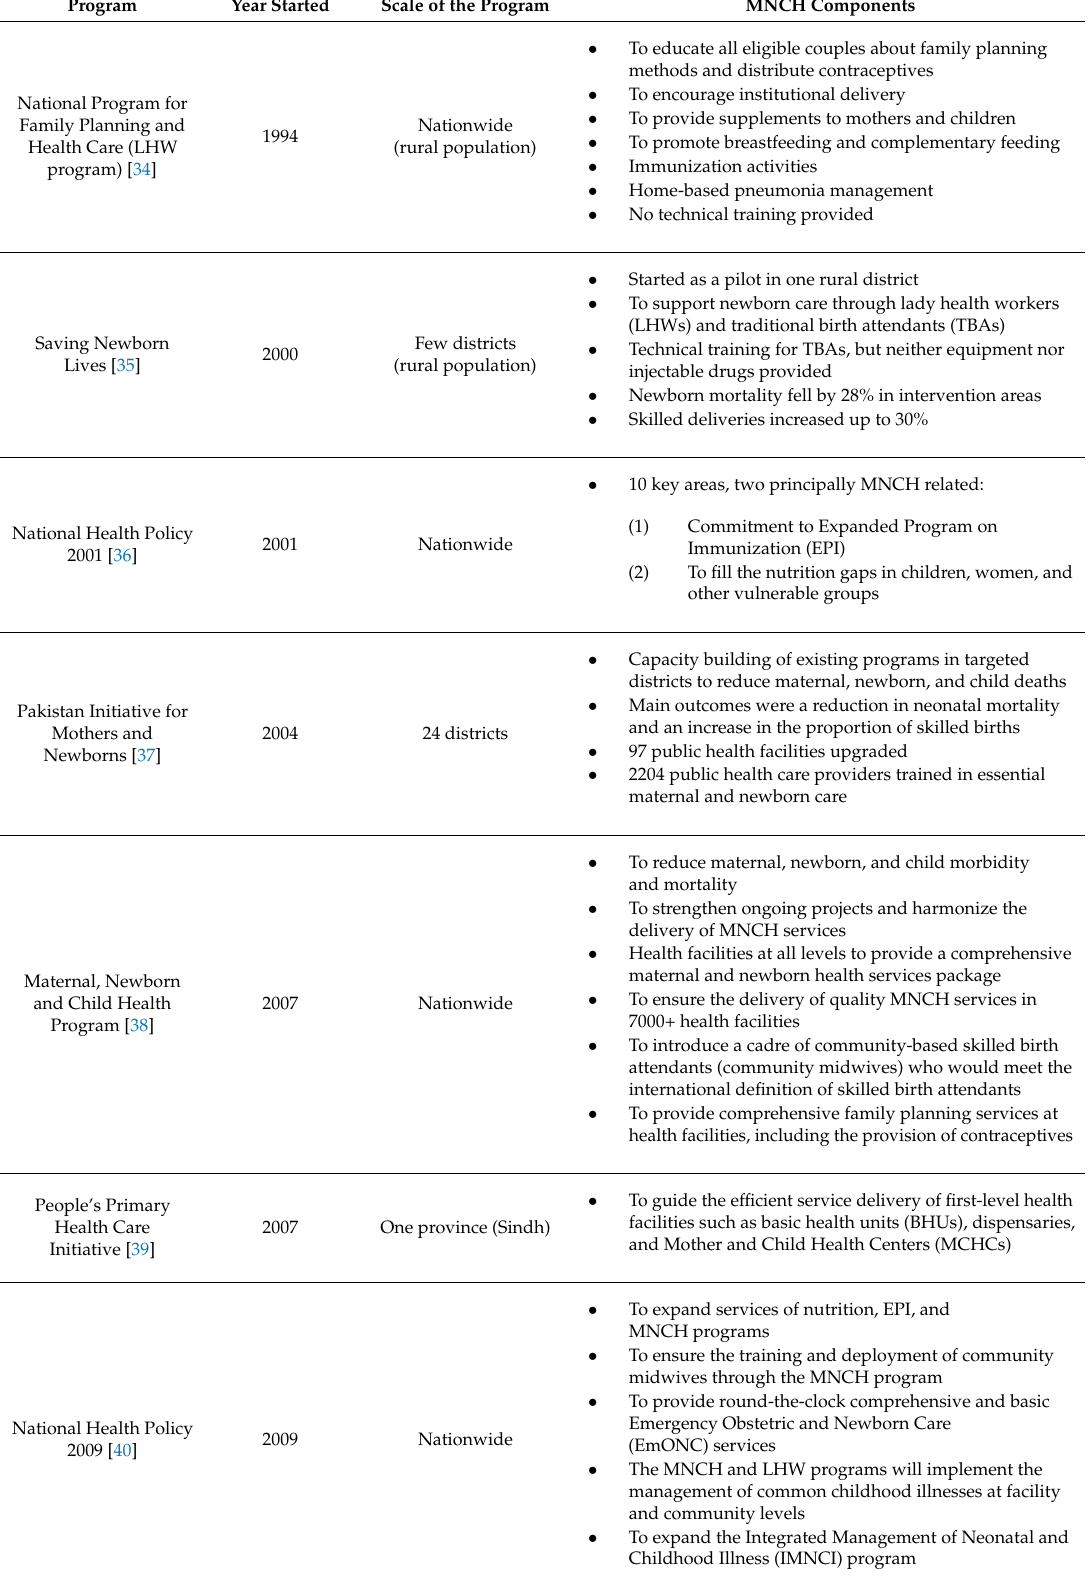
Table 3. Public health policies and programs with MNCH components in